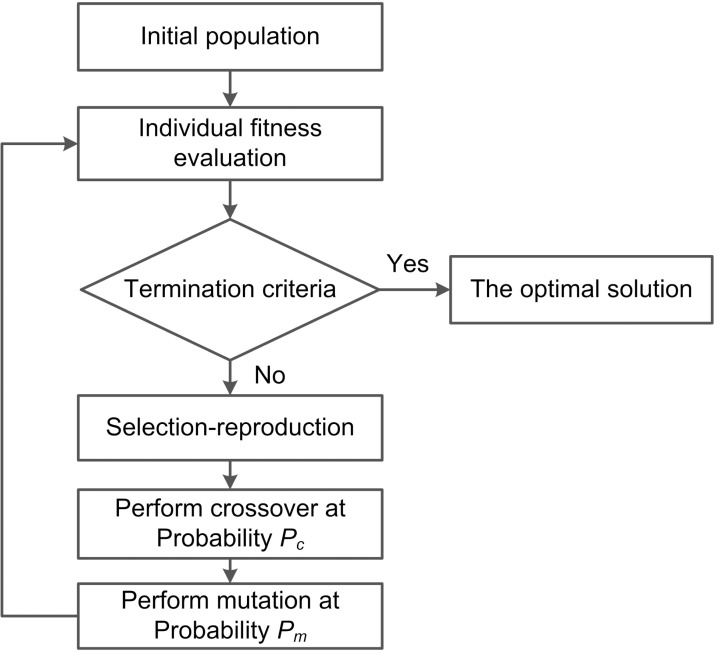
Flow chart of GA.